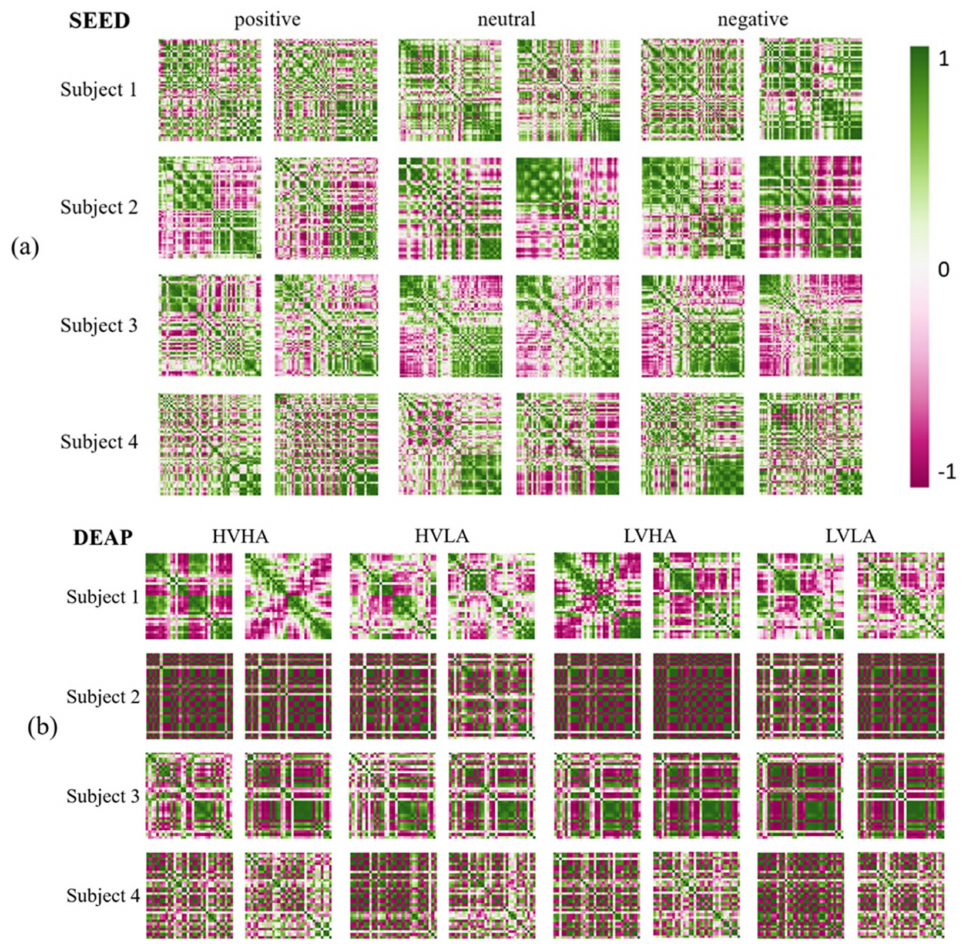
Figure 6. Visualization of channel-wise features and comparison between di ff erent subjects and trials. Channel-wise features are from ( a ) the SEED and ( b ) the DEAP.